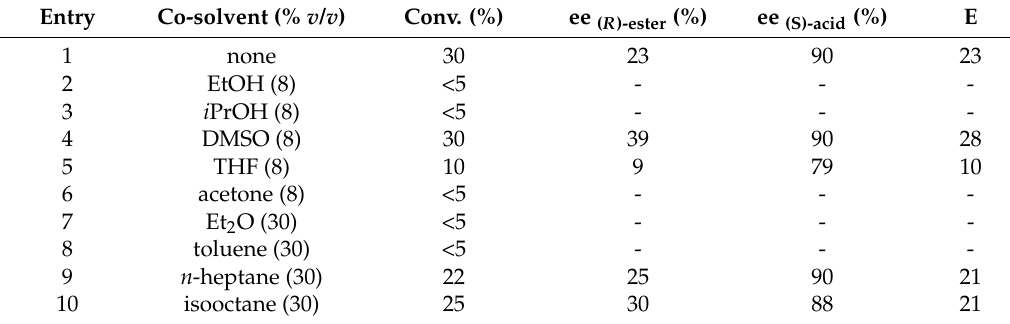
Table 3. Hydrolysis of 1e with PLE in the presence of different co-solvents. Conditions: [S] = 8 mM,